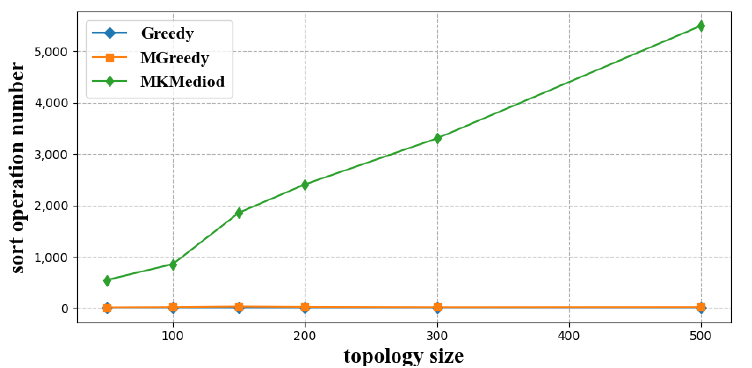
Figure 6. Number of sort operations of each algorithm with different network sizes—detailed